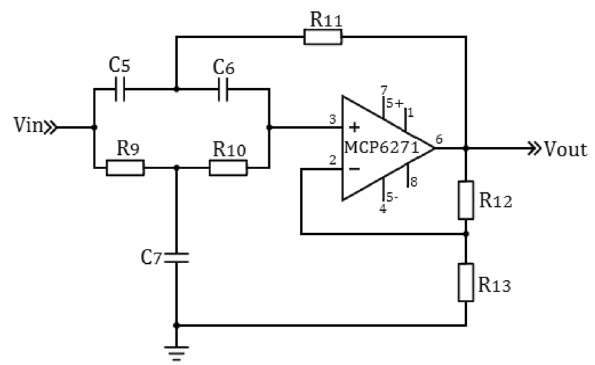
Fig. 5 Twin T notch